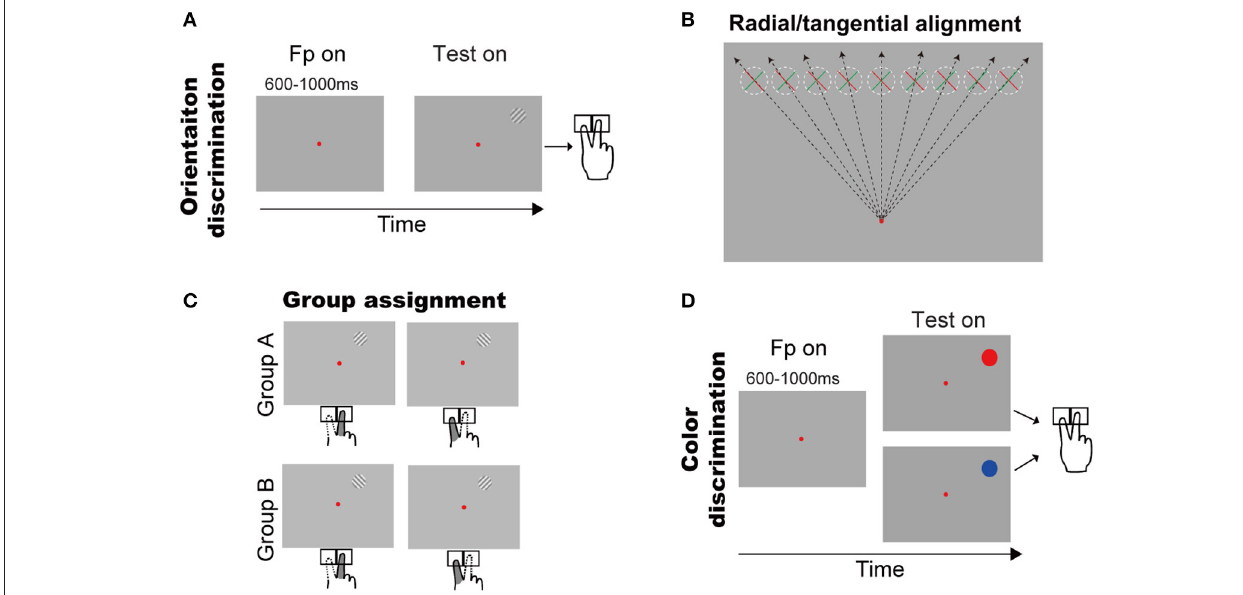
FIGURE 1 | Behavioral tasks and the two groups of subjects. (A) Orientation discrimination task. A trial started with a small red fixation point and subjects fixated on it. After a random delay, a grating appeared in upper visual field. Subjects had to press a left or right key to report the grating orientation (see Methods and Results for details). (B) Illustration of the grating orientations respect to the fixation point. The dashed circles indicate the grating possible locations across trials and green/red bar indicates grating with + 45 ◦ / − 45 ◦ . (C) Illustration of finger responses to the gratings in two groups. (D) Color discrimination task. A trial started with a small red fixation point and subjects fixated on it. After a random delay, a color patch (red or blue) appeared in upper visual field. Subjects had to press a left or right key to report the color of